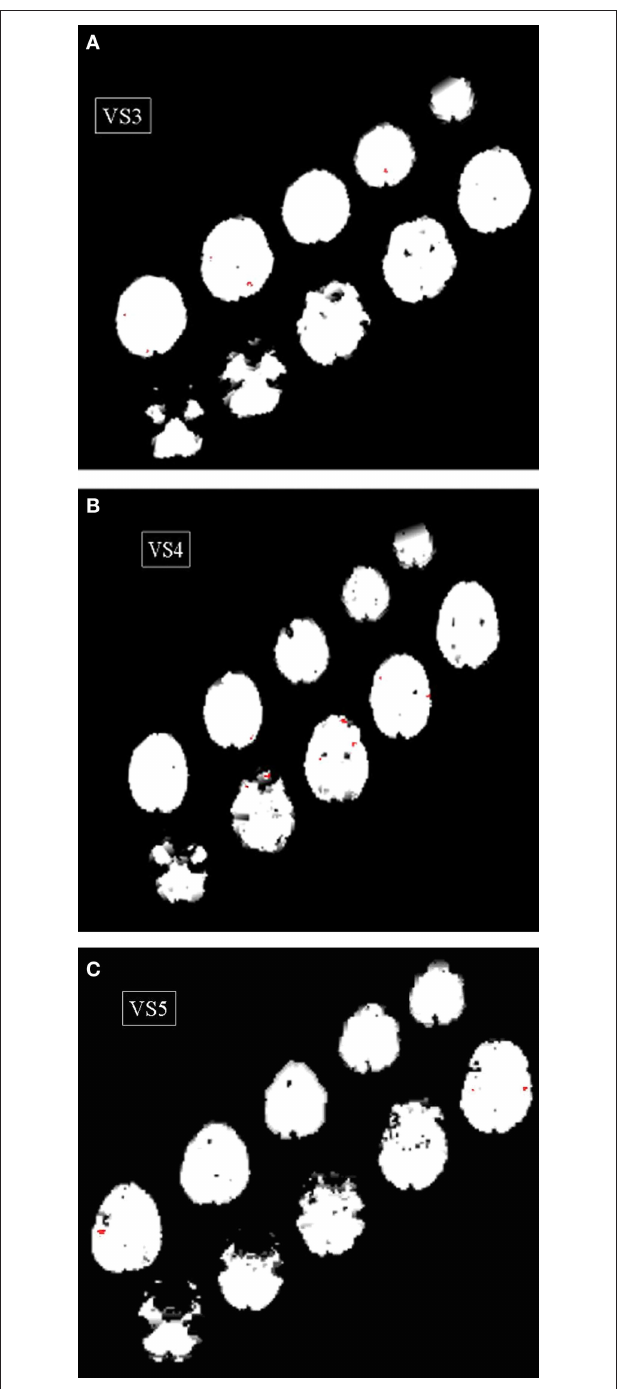
Figure A3 | results of the right vs. rest movement contrast (red) superimposed on the original SPM masks for VS3 (A) , VS4 (B) , and VS5 (C) .